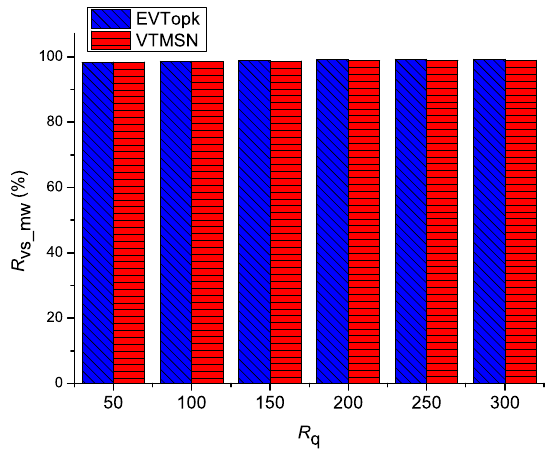
Figure 9. R vs _ mw with different settings of R q